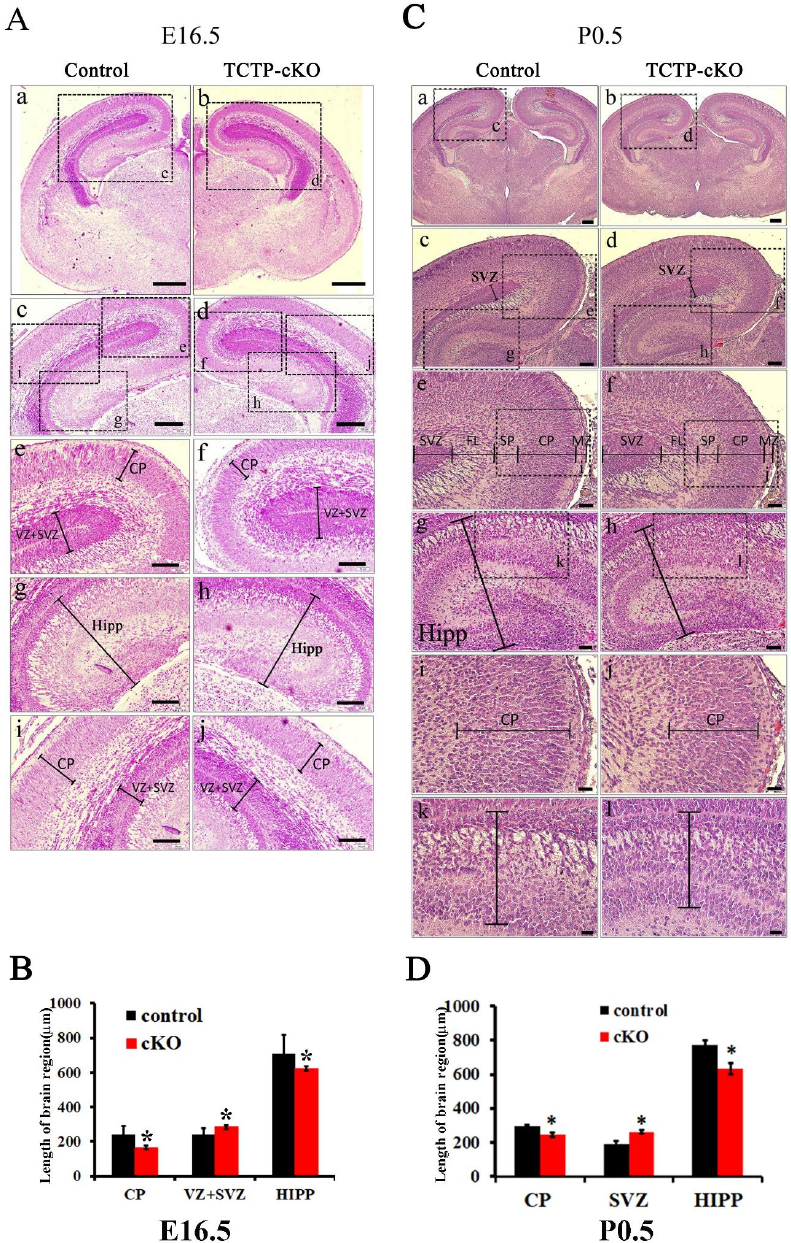
Figure 4. Histological analysis of E16.5 embryos and P0.5 pups from control and cKO mice. ( A ) Control ( Nestin Cre /+ ; TCTP w / w ; a, c, e, g, and i) and cKO ( Nestin Cre /+ ; TCTP f / f ; b, d, f, h, and j) brain sections from E16.5 embryos were stained with hematoxylin and eosin. ( B ) Bar graph summarizing quantification of the sizes of brain regions in ( A ). ( C ) Control (a, c, e, g, i, and k) and cKO (b, d, f, h, j, and l) brain sections from P0.5 pups were stained with hematoxylin and eosin. ( D ) Bar graph summarizing the quantification of the sizes of brain regions in ( C ), (data presented as mean ± SEM, * p < 0.05, Student’s t test, n = 3 per group). A representative image is shown for three independent experiments. MZ, marginal zone; SP, subplate. Scale bars on panel A: a, b, 400 µ m; c, d, 200 µ m; e–j, 100 µ m. Scale bars on panel B: a, b, 400 µ m; c, d, 200 µ m; e–h, 100 µ m; i–l, 40 µ